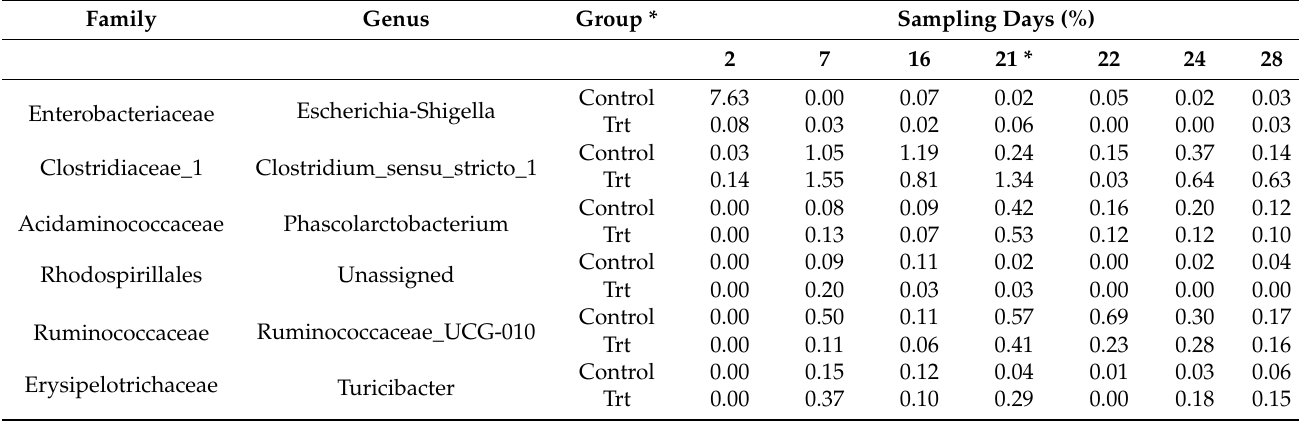
Table 5. Comparisons of the relative abundances (median, %) of six genera identified by ANCOM analysis that varied significantly between the control and treatment groups by sampling days in the last week (days 21, 22, 24 and 28) of the study period. All are significant ( p <